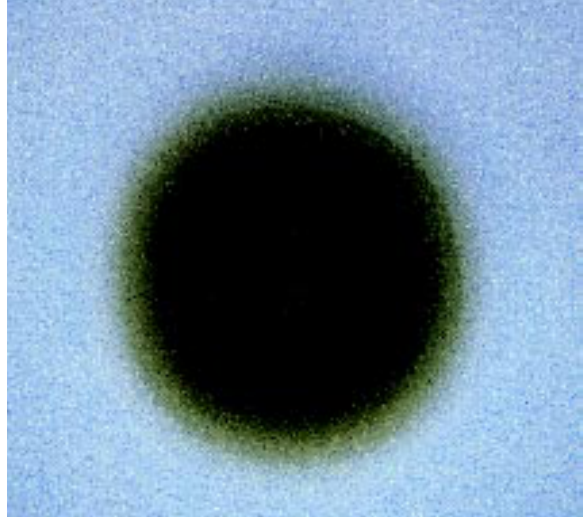
Fig. 3. A three week old colony of Phaeoacremonium chlamydosporum growing on malt agar, isolated from a declining vine, cv. Victoria/775